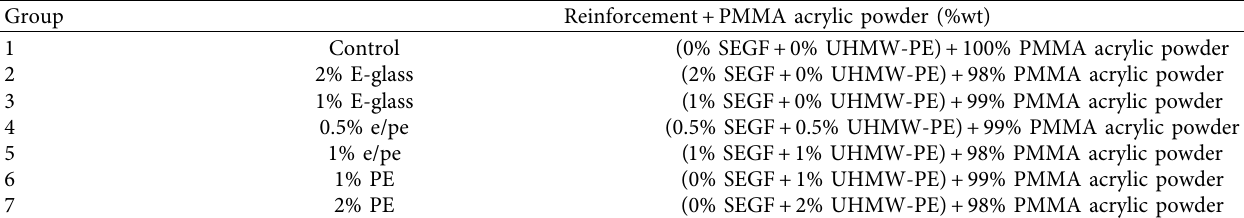
Table 1: Specimen grouping according to acrylic powder, short E-glass fiber, and ultra-high-molecular-weight polyethylene filler percentage.